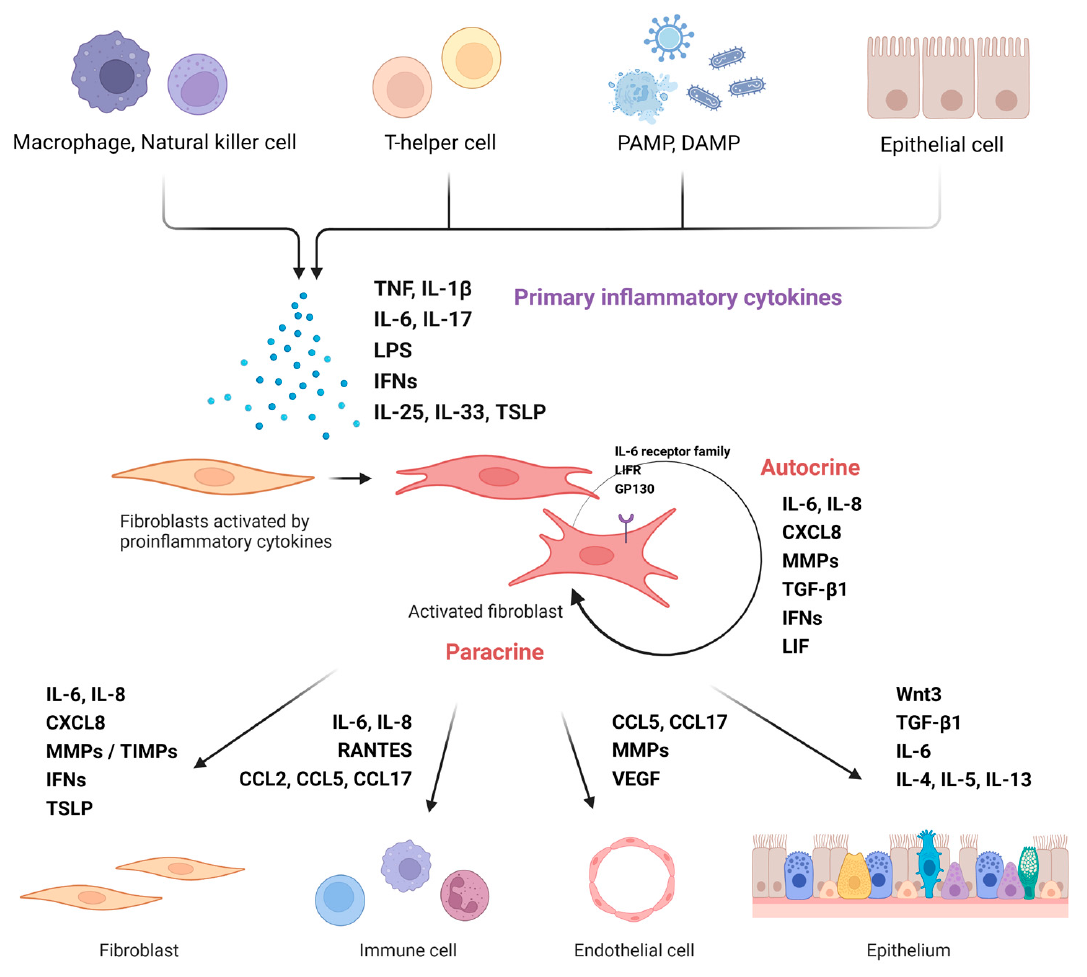
Figure 1. Nasal fibroblast activation and modulation of surrounding cells. Activation of nasal fibro- blasts induced by immune cells or external antigens regulates various structural cells or immune cells in tissues. (Figure created using Biorender.com).